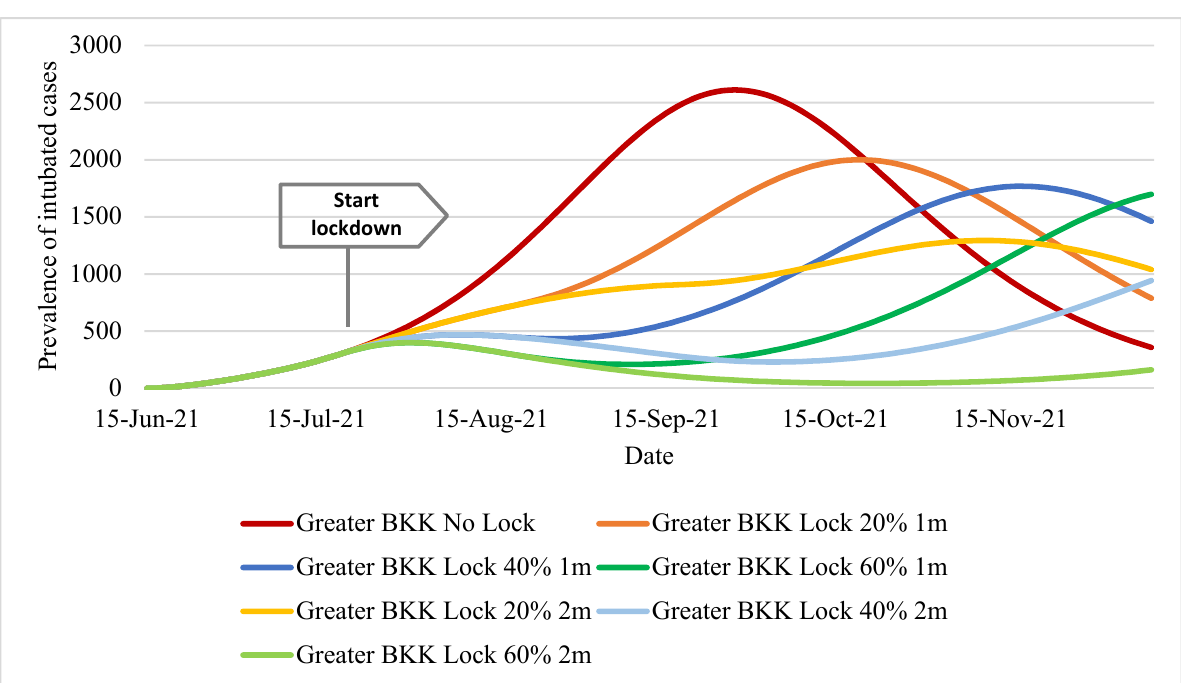
Figure 5. Prevalent reported intubated cases in Greater Bangkok.